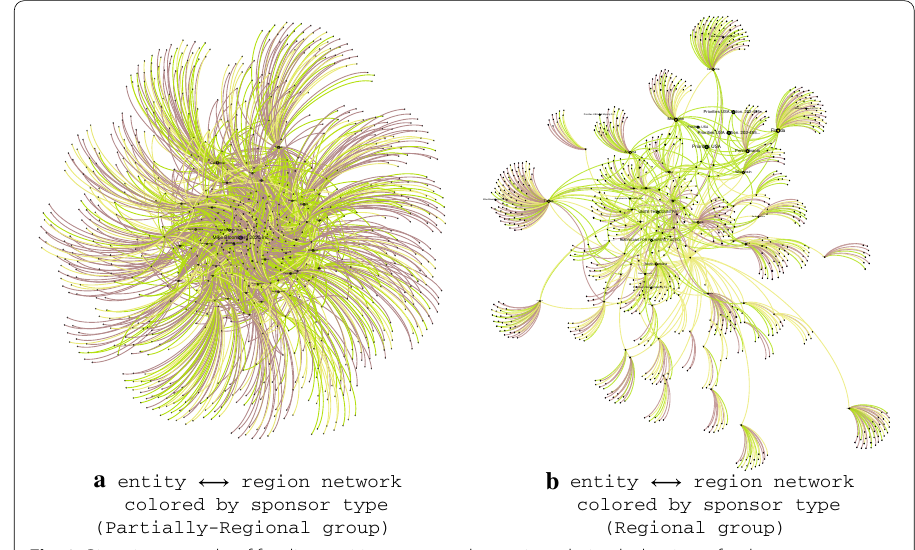
Fig. 9 Bipartite networks of funding entities connected to regions their ads dominate for the Partially-Regional group (left) and the Regional group (right). Region nodes are yellow, whereas entity nodes are colored according to sponsor type: green for groups, purple for campaigns, and grey for unlisted/other. High-spending entity nodes are larger if they spend more in the network, and region nodes are larger if more was spent on them in the network. Entity nodes are labeled with their “disclaimer” component. The weight and label of an edge from entity E to region R reflects E ′ s total spend on ads dominated by R . Both networks were visualized in Gephi (Bastian et al. 2009) using the same layout algorithm (Hu 2005) and same parameters (colors, size, spline,